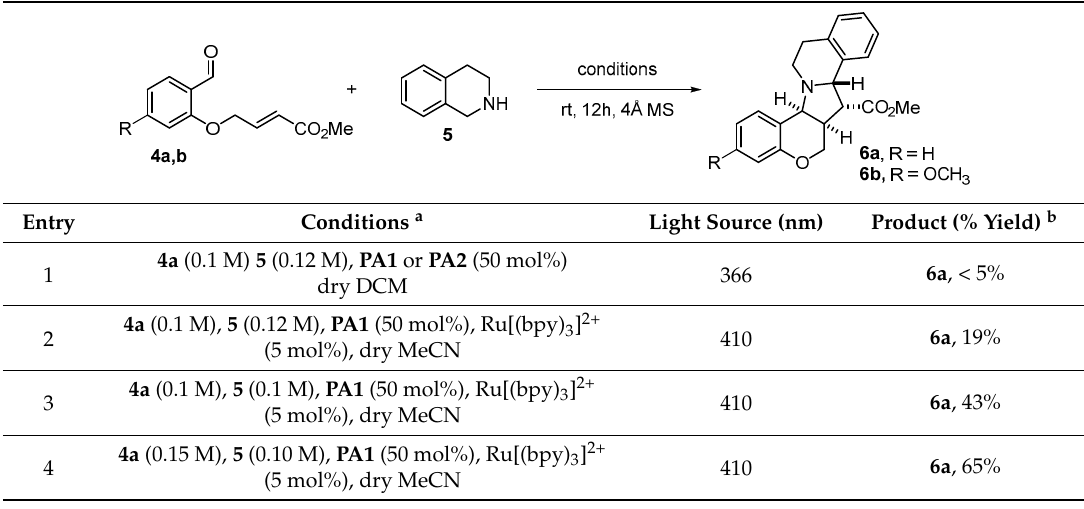
Table 2. Acid induced synthesis of alkaloids 6a , b .